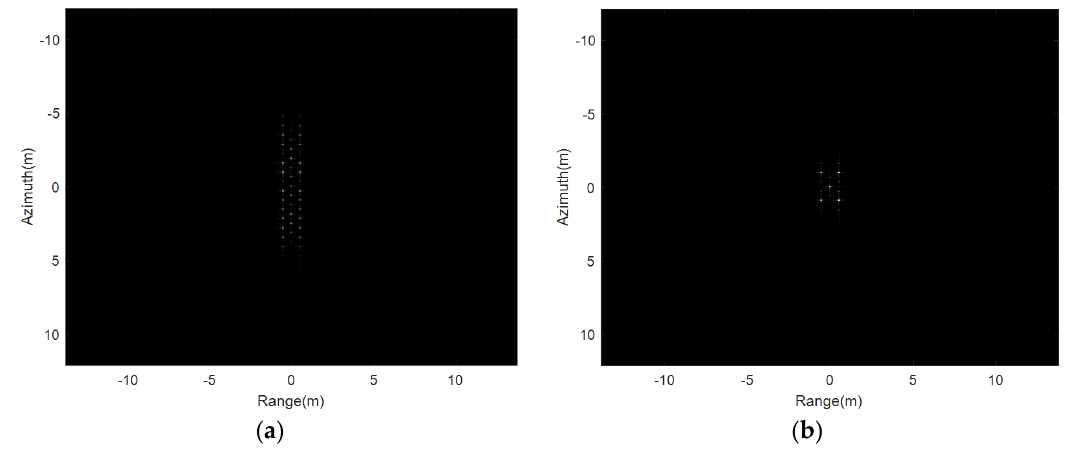
Figure 8. Imaging results of multi-point targets. ( a ) RD algorithm; ( b ) the propose algorithm.